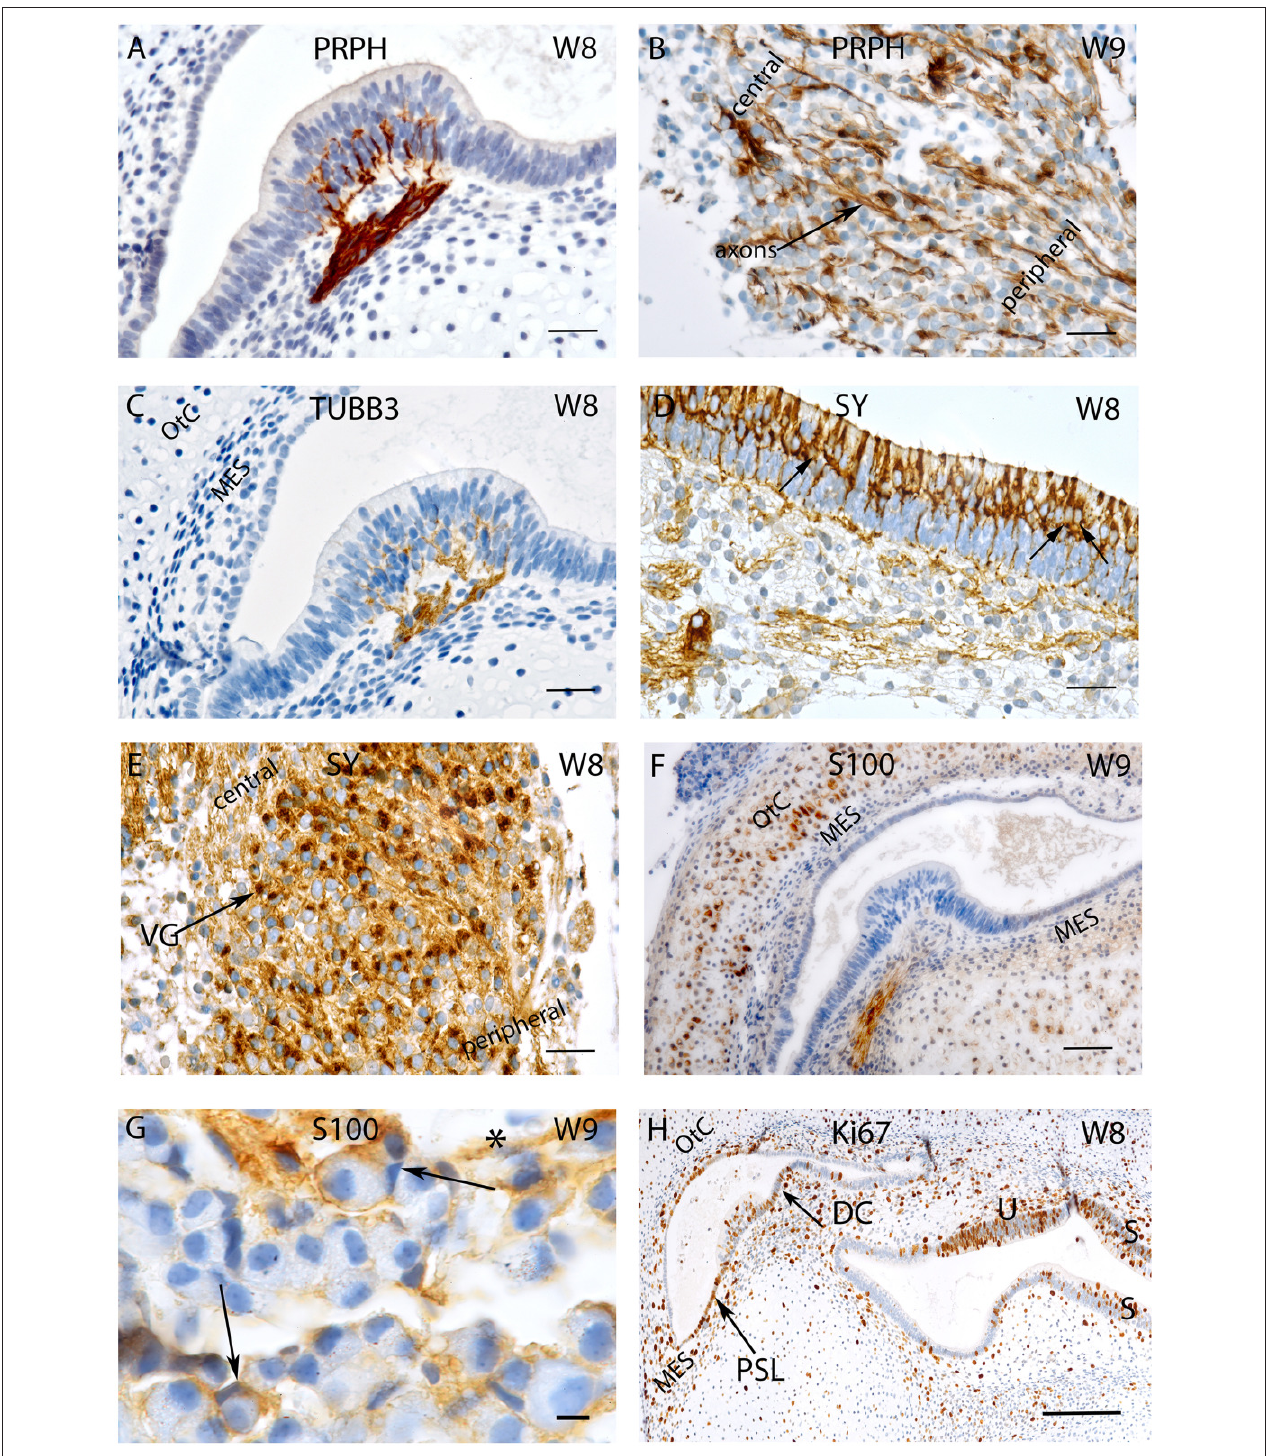
FIGURE 1 | Sections of the developing VO between W8 and W9. (A) Peripherin staining in the Crista ampullaris (intensely stained Peripherin positive fibers are invading the sensory epithelium) and (B) the vestibular ganglion; peripheral as well as central axons of the vestibular nerves are immunoreactive. Fibers immunoreactive for TUBB3 are innervating the sensory epithelia of a crista ampullaris (C) by W8. The otic capsule (OtC) and the mesenchyme (MES) are all unstained. (D) Synaptophysin stained nerve fibers innervate the sensory epithelia of the developing utricule where immunoreactive hair cells and intensely stained nerve endings